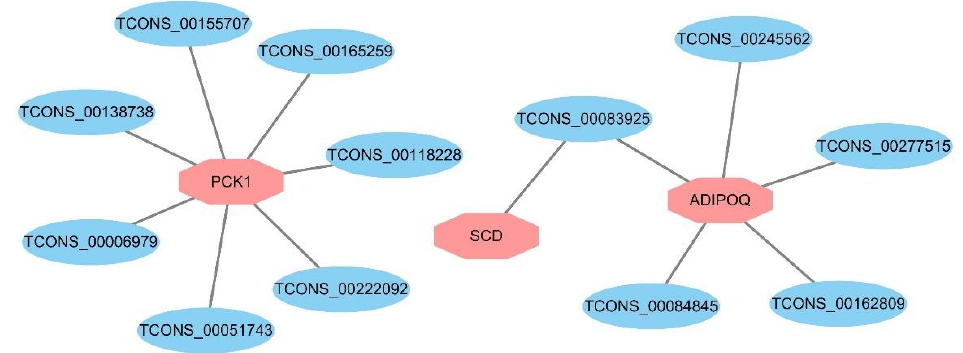
Figure 4. Correlation networks for DELs and their target genes. Rhombuses represent 3 target genes, ellipses represent 12 DELs.